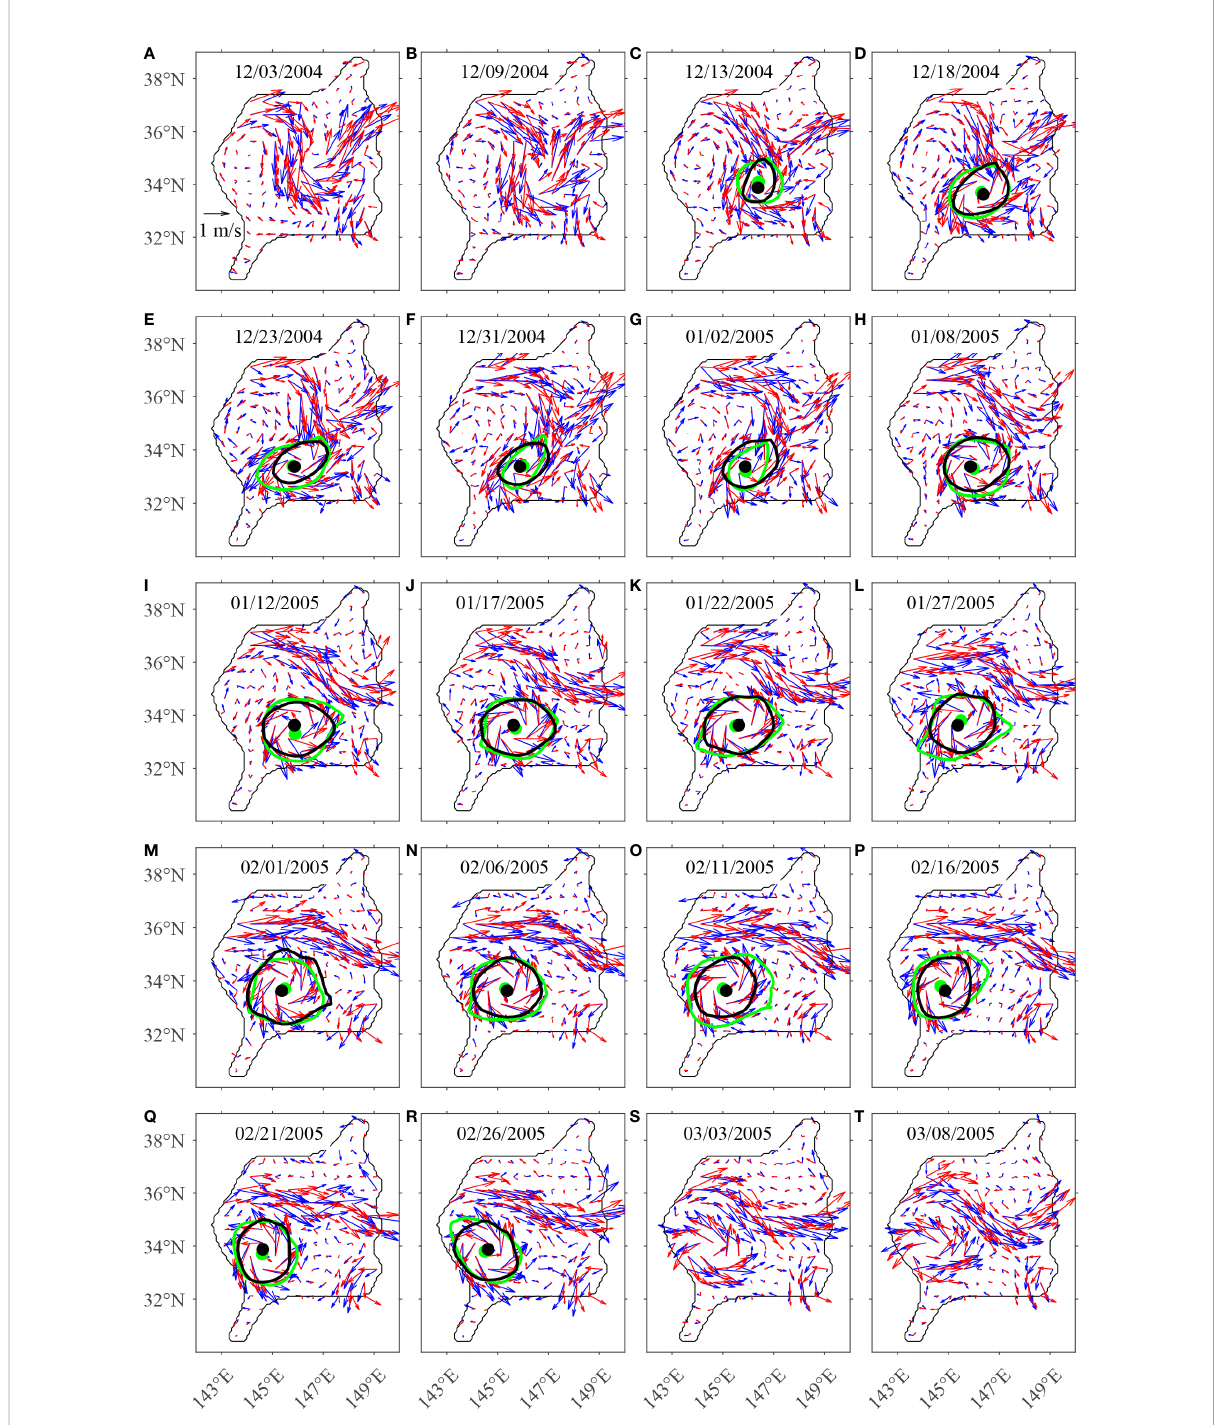
FIGURE 3 Comparison of the surface currents from the satellite altimeter (red) and Kuroshio Extension System Study (KESS) observations (blue). The thin black line shows the observation area, the thick green and black lines mark the current- and pressure-equipped inverted echo sounder (CPIES)- detected and satellite-detected eddy boundaries,